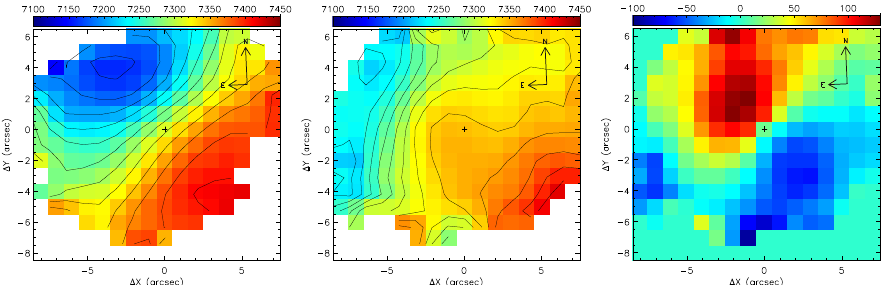
Fig. 1. MPFS data of Mrk 198: velocity (cid:12)elds in H (cid:11) (left), [O III] (middle) and [O III] residual velocity map (right).